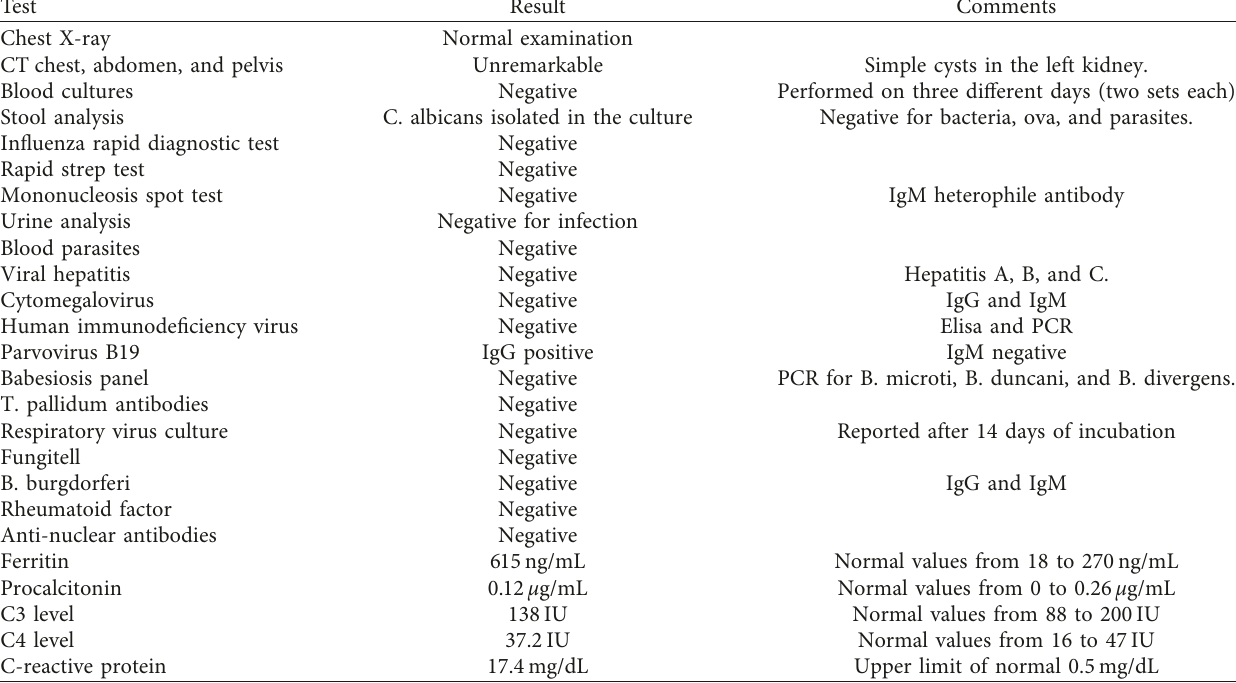
Figure 2: Daily leukocyte trend throughout the admission in the hospital. Table 1: Infectious and immunologic work-up performed during the